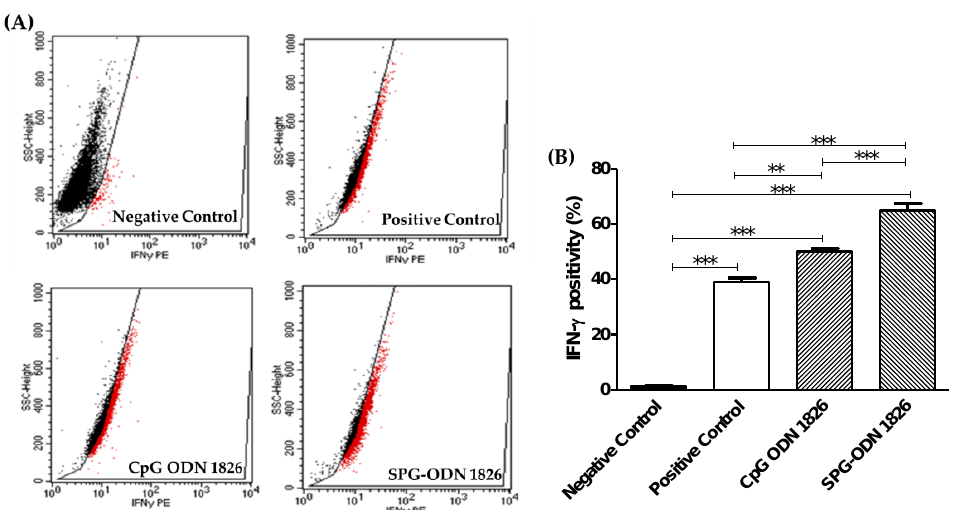
ture inflammatory cytokines in J774A.1 cells. The analysis elucidated that there was a sub- stantial escalation of 1.28-fold in the IFN- γ -positive cell population within J774A.1 cells treated with TLR-9 agonist (50.12% ± 1.07%) compared to LPS-stimulated cells (38.97% ± 1.56%; p < 0.01). Treatment with formulated nanovehicles further enhanced the IFN- γ - positive population of M ϕ s (64.87% ± 2.57%) by slightly more than 1.5-fold in comparison to the LPS-stimulated positive control ( p < 0.001; Figure 5).